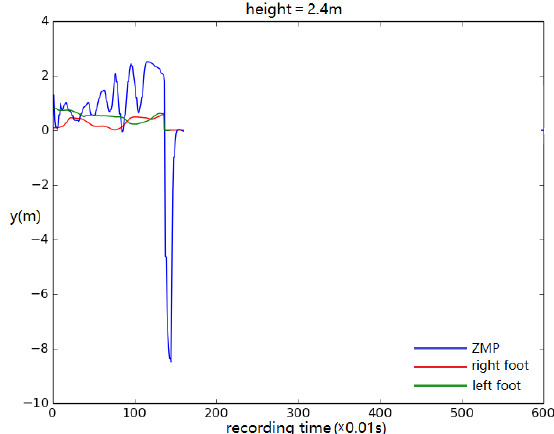
Figure 15. Foot and ZMP displacement when the body height is set to 2.4 m. Displacement of torso center of mass vs.